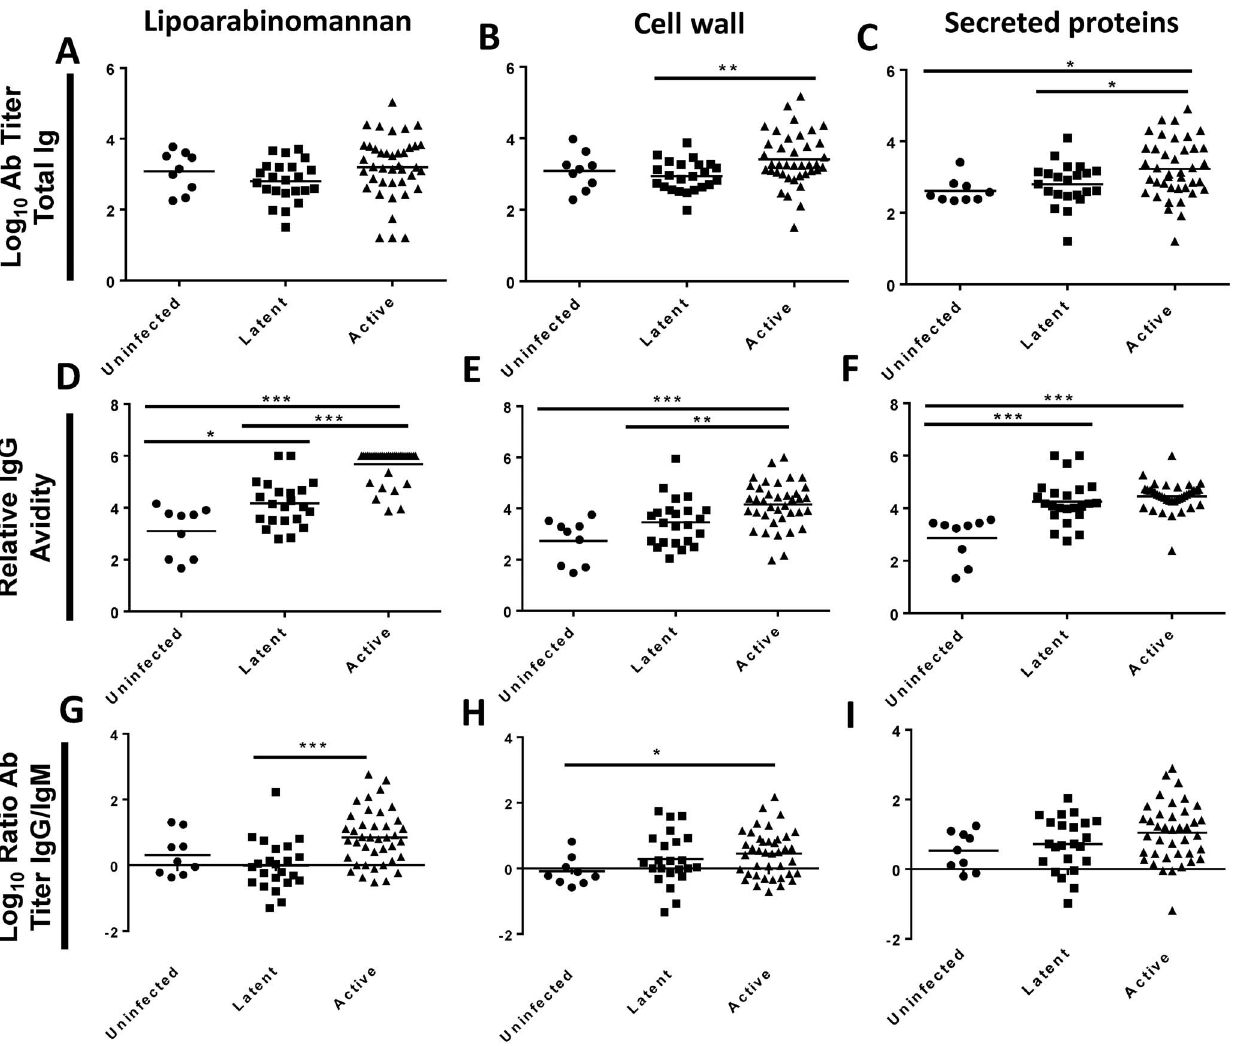
Figure 2. Antibody (Ab) responses to M.tuberculosis to lipoarabinomannan, cell wall, and secreted protein fractions. Plasma from PPD-negative volunteers (Uninfected), patients with latent TB infection (Latent), or patients with active TB disease (Active) were assayed by ELISA against the surface of live M. tuberculosis H37Rv or H37Rv whole cell lysate. ( A–C ) Log 10 total Ig titers. ( D–F ) Relative IgG avidity. ( G–I ) Log 10 ratio of IgG to IgM titers. Two-sided p-values by student’s t-test or Mann-Whitney test: (*) p # 0.05, (**) p # 0.01, (***) p #